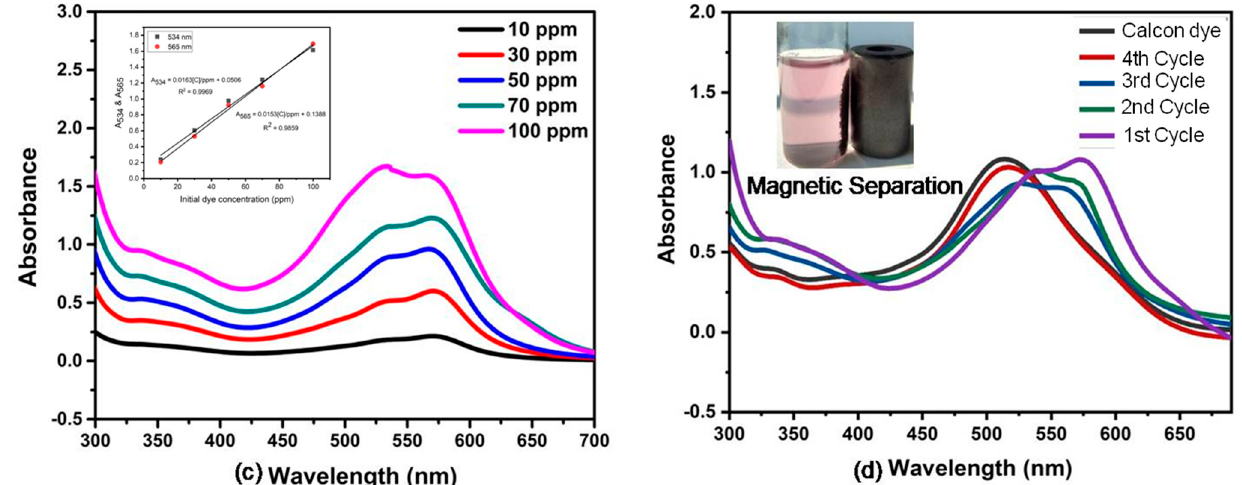
Figure 5. ( a ) UV − vis spectrum of Calcon dye degradation with varies time; ( b ) comparative plot of degraded products using contact time; ( c ) Effect of initial dye concentration and ( d ) UV spectrum of recycled SWPS/MNp (20 wt%) with magnetic separation.